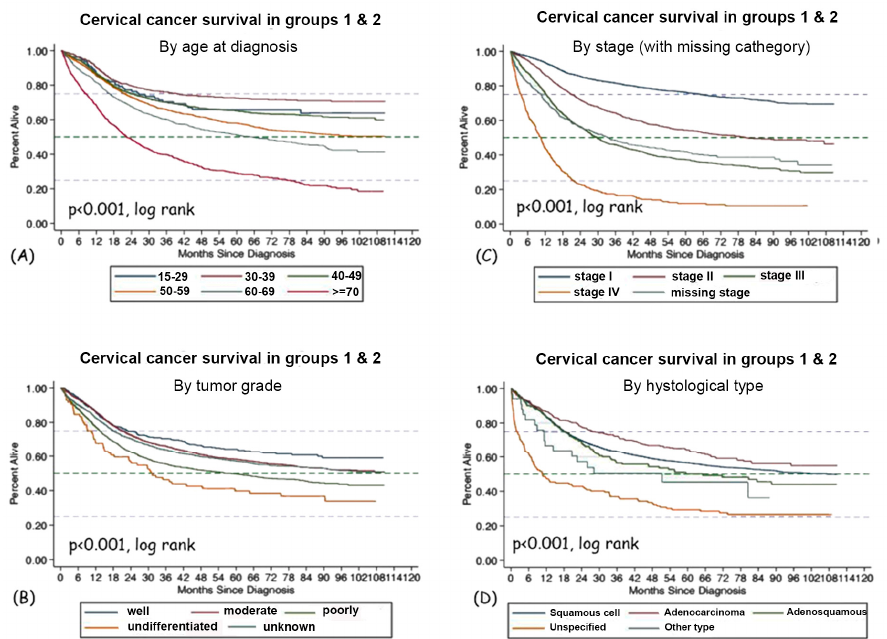
Figure 7. Survival according to different prognostic indicators: age at diagnosis (A); tumor grade (B); stage (C ) and histological type (D)